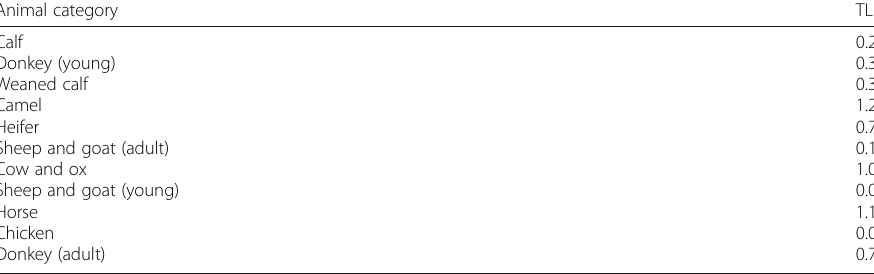
Table 10 Conversion factors used to estimate tropical livestock unit (TLU) equivalents Animal category TLU Calf Donkey (young) Weaned calf Camel Heifer Sheep and goat (adult) Cow and ox Sheep and goat (young) Horse